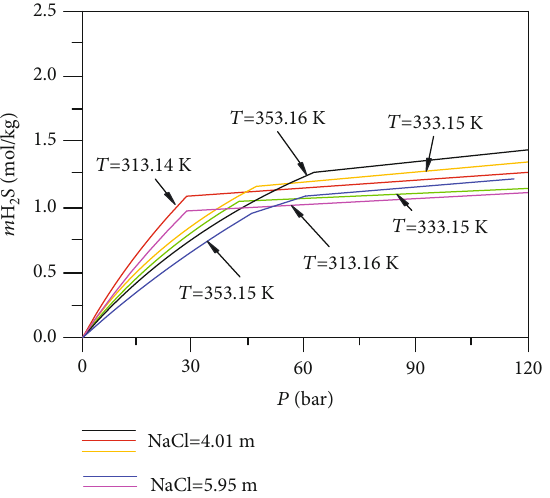
Figure 9: Solubility of H